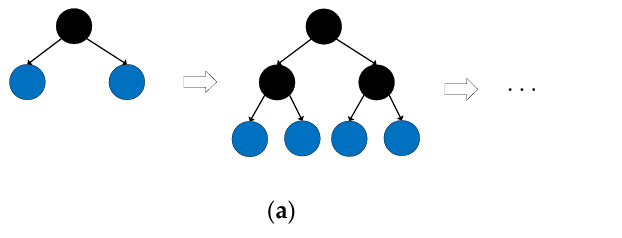
Figure 2. Comparison of ( a ) level-wise growth strategy and ( b ) leaf-wise growth strategy.